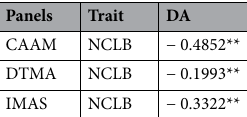
Table 3. Genetic correlation between the Northern corn leaf blight (NCLB) scores and days to anthesis (DA) for CIMMYT Asia Association Mapping (CAAM), Drought Tolerant Maize for Africa (DTMA) and Improved Maize for African Soils (IMAS) panels. DA days to anthesis. ** P value ≤ 0.001.